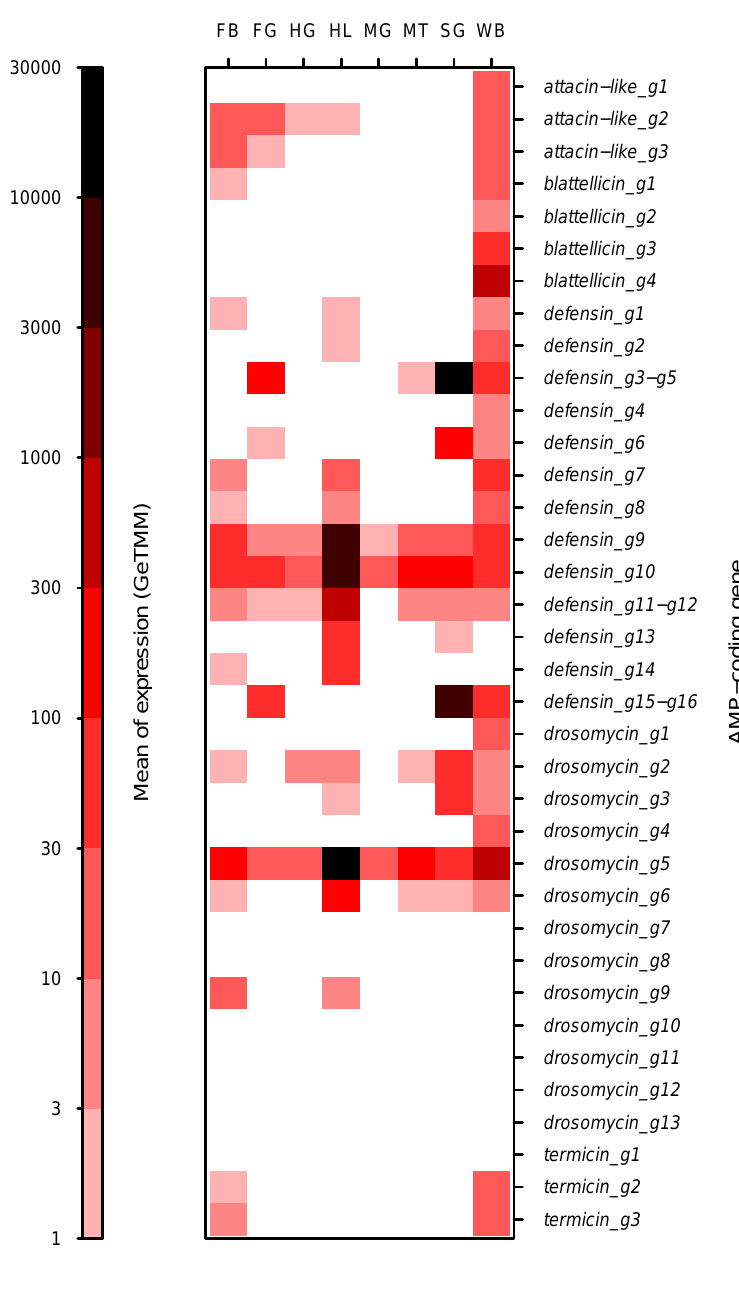
Figure 3. Gene expression of AMP genes in seven sample types and whole bodies of B. germanica . Heatmap analysis of normalized expression (GeTMM) of AMP genes. Genes with identical CDS were grouped. The levels of expression in whole bodies (WB) are the means of three female adult SRA projects (SRR5458592.1, SRR5458593.1 and SRR6784711.1). See Figure 2 for abbreviations of sample types. GeTMM values < 1 are in